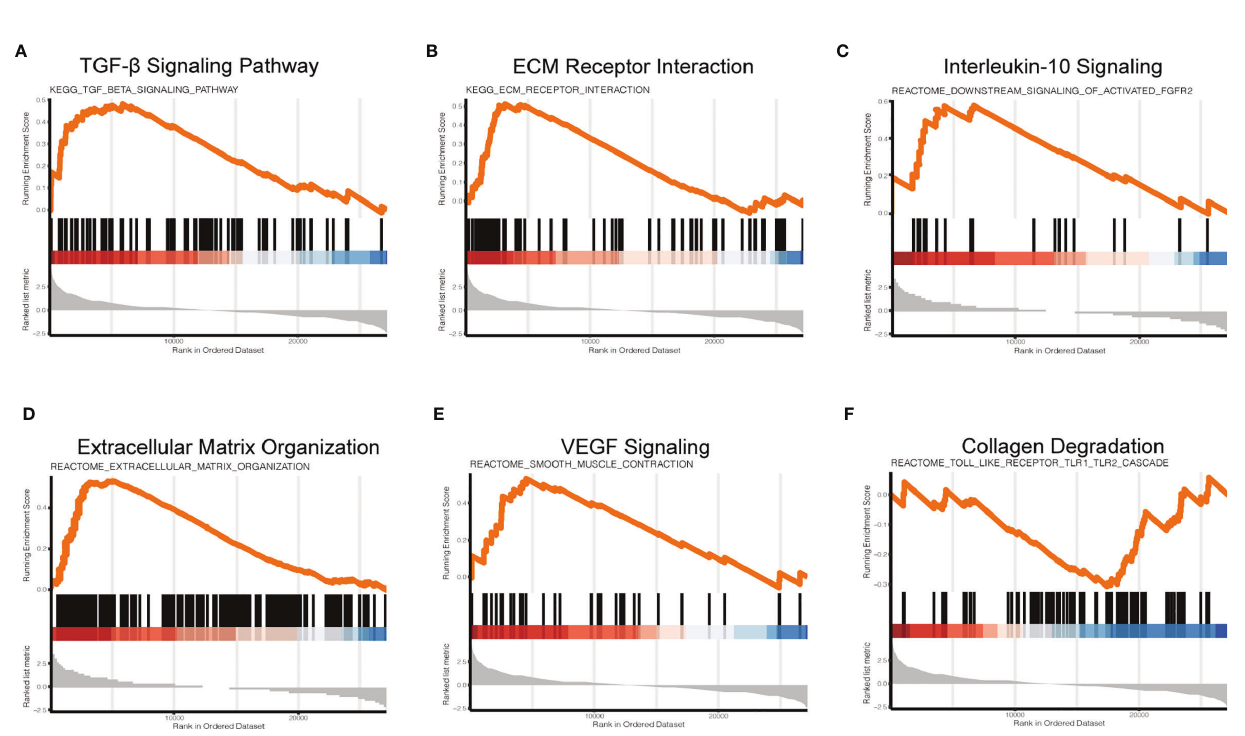
FIGURE 4 | Gene set enrichment analysis (GSEA) to investigate changes in signaling pathways in macrophages after NPVs treatment. (A) is the TGF- b signaling pathway, (B) is ECM receptor interaction, (C) is IL-10 signaling, (D) is extracellular matrix organization, (E) is VEGF signaling, and (F) is collagen degradation.